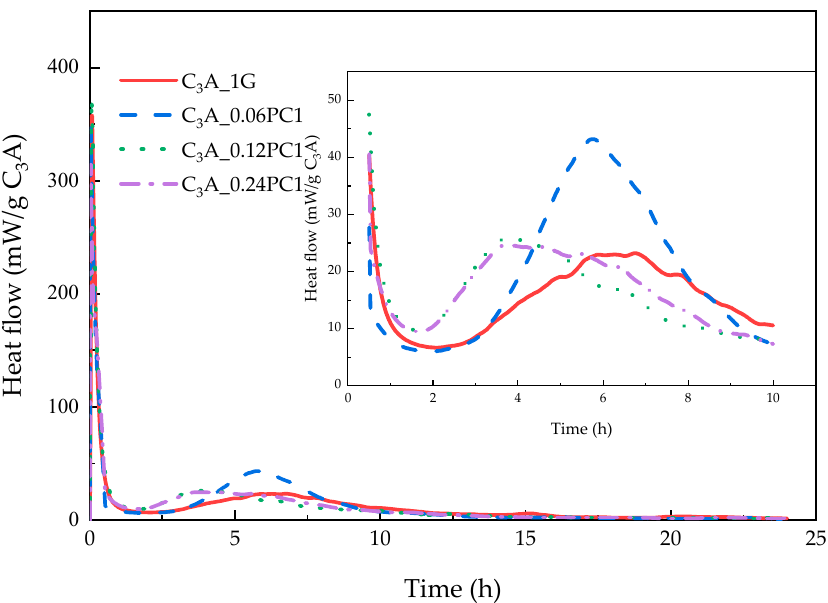
Figure 4. Heat evolution curves of C 3 A-gypsum with different concentrations of PC1 solution during the 24-h hydration.